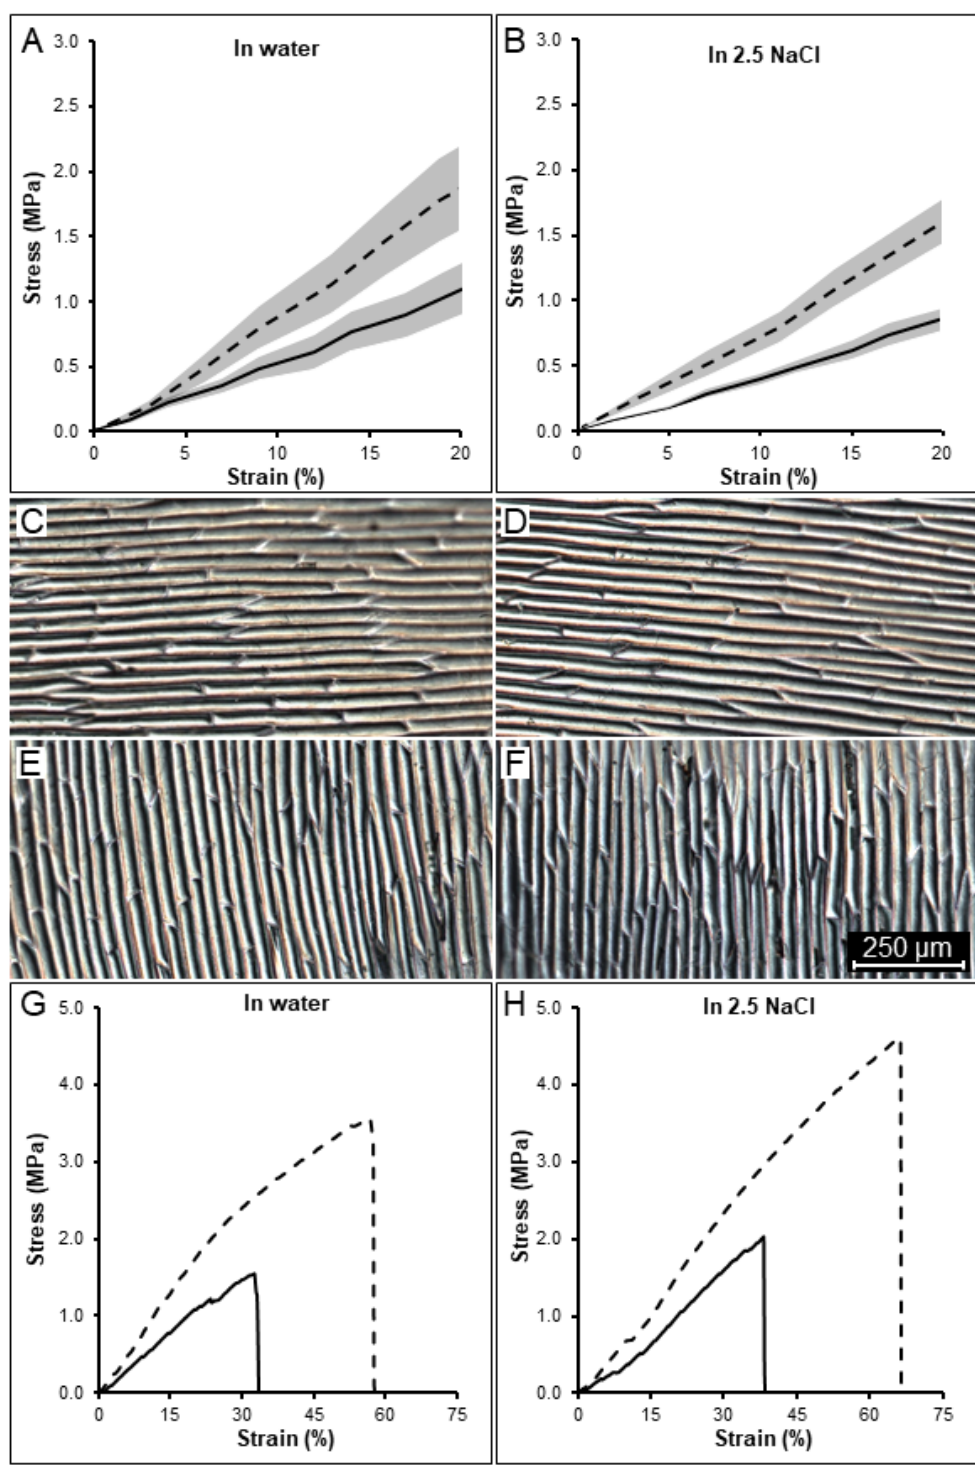
Figure 2. Tensile testing of onion epidermal tissues oriented in longitudinal and transverse directions. Tissue stretching in turgid ( A , C , E , G ) and plasmolyzed ( B , D , F , H ) conditions. ( A , B , G , H ) Normalized strain–stress curves generated from the microextensometer experiment in the longitudinal (dashed line) and transverse (solid line) directions for all samples ( A , B ) and a typical single sample ( G , H ). The grey ranges indicate the confidence intervals based on standard errors ( C – F ) Close-up of the adaxial onion epidermal peels used for tensile testing showing the cell size and patterning. The scale bar is shown in the figure.